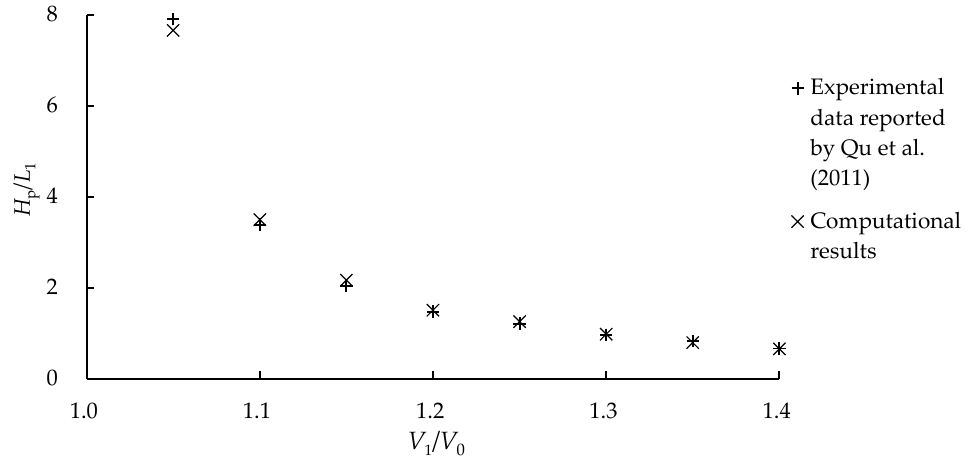
Figure 4. The H p / L 1 relationship with V 1 / V 0 , obtained by comparing data from the CLSVOF method to experimental data reported by Qu et al. [15].